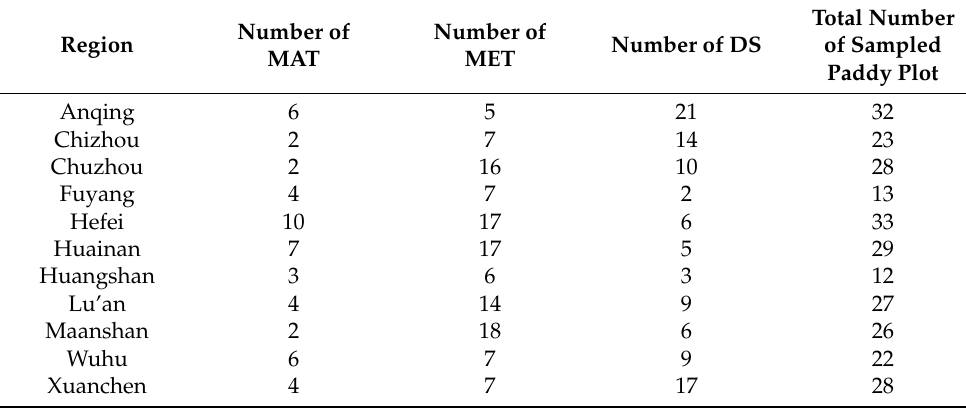
Table 2. The distribution of sampled paddy plots in the present